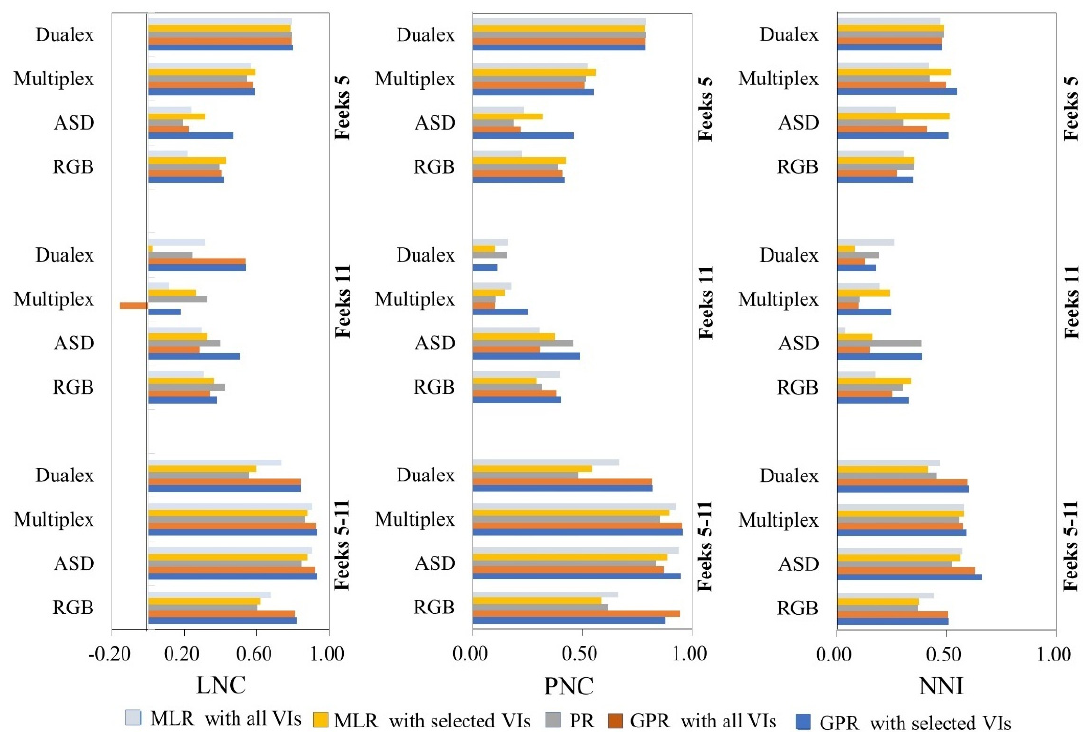
Figure 4. The NSE for LNC ( left ), PNC ( middle ), and NNI ( right ) estimation with different sensors through PR, MLR, and GPR methods.